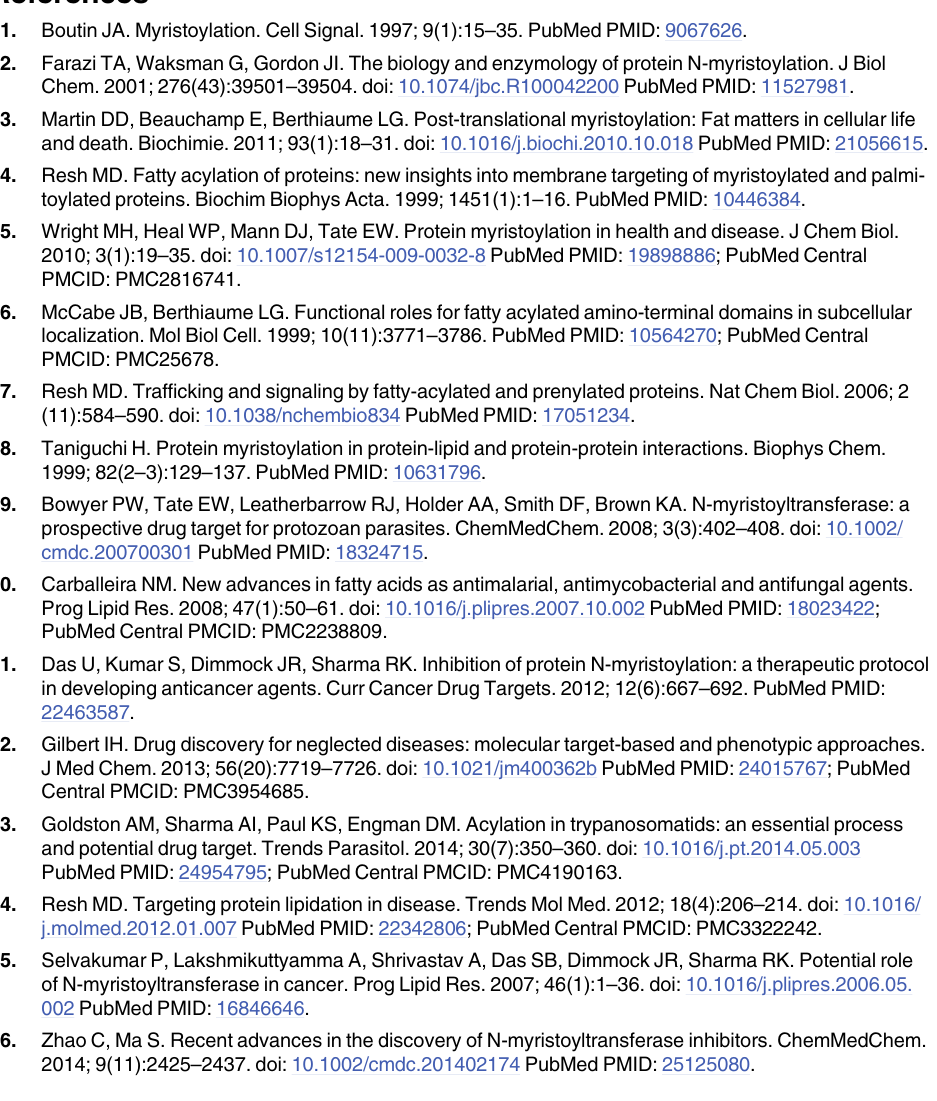
S1 Table. List of plasmids used in the study and their characteristics.